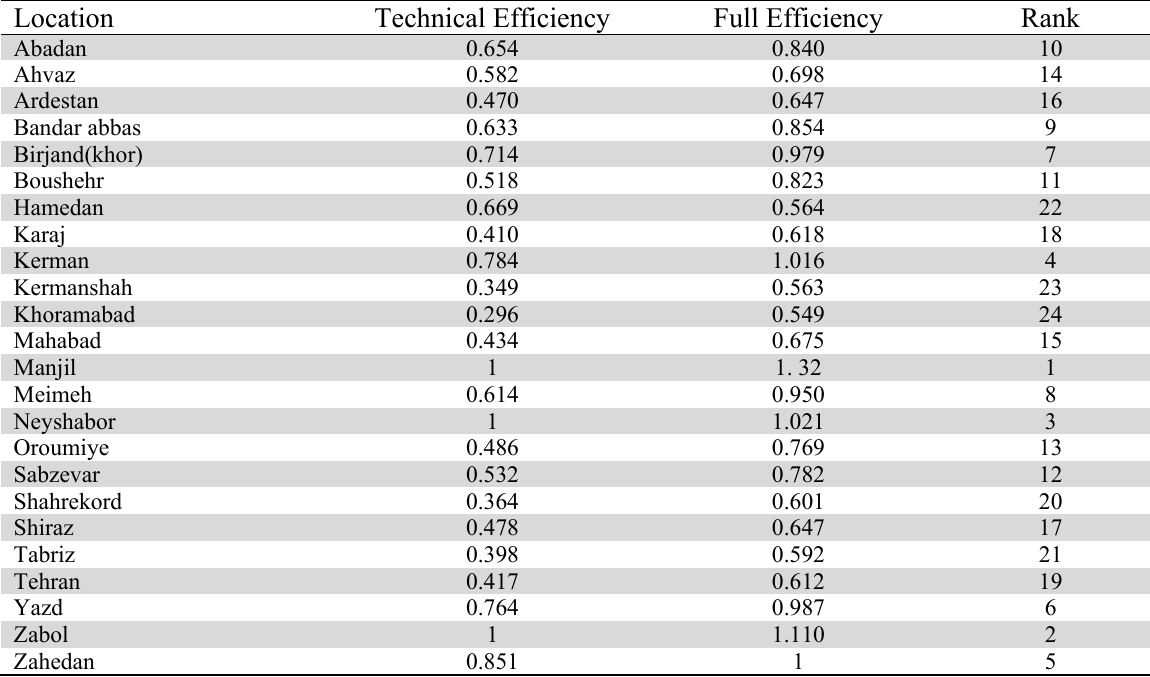
Efficiency scores and ranking the nominated locations